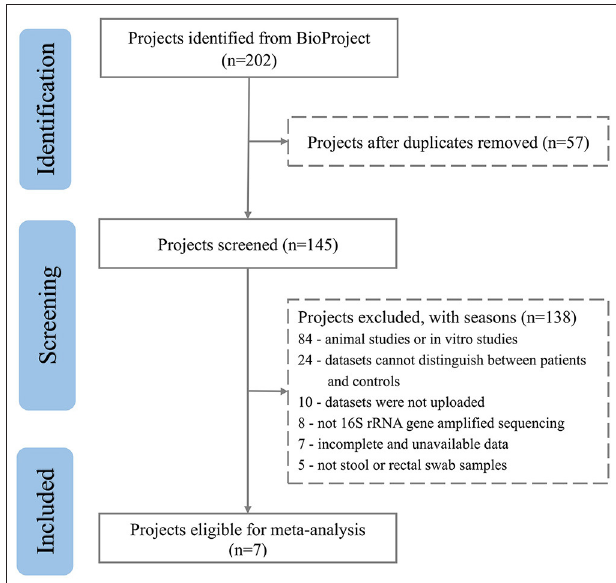
FIGURE 2 | PRISMA flow diagram depicting the screening process from the Bioproject database for inclusion of studies.